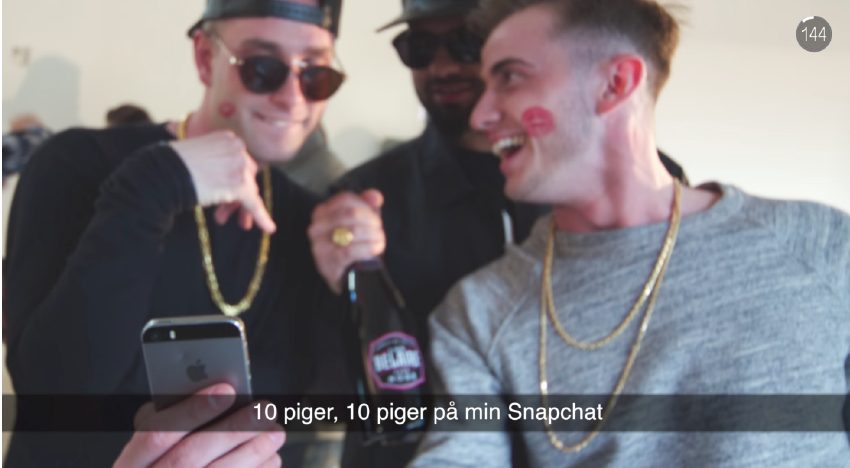
Figure 22. Screenshot from the music video “Ladies in stock”, with the text: “Ten girls, ten girls on my Snapchat,” in Danish. Released in 2016 on Jimilian’s third studio album Me and Myself (Jamilian, 2016). May